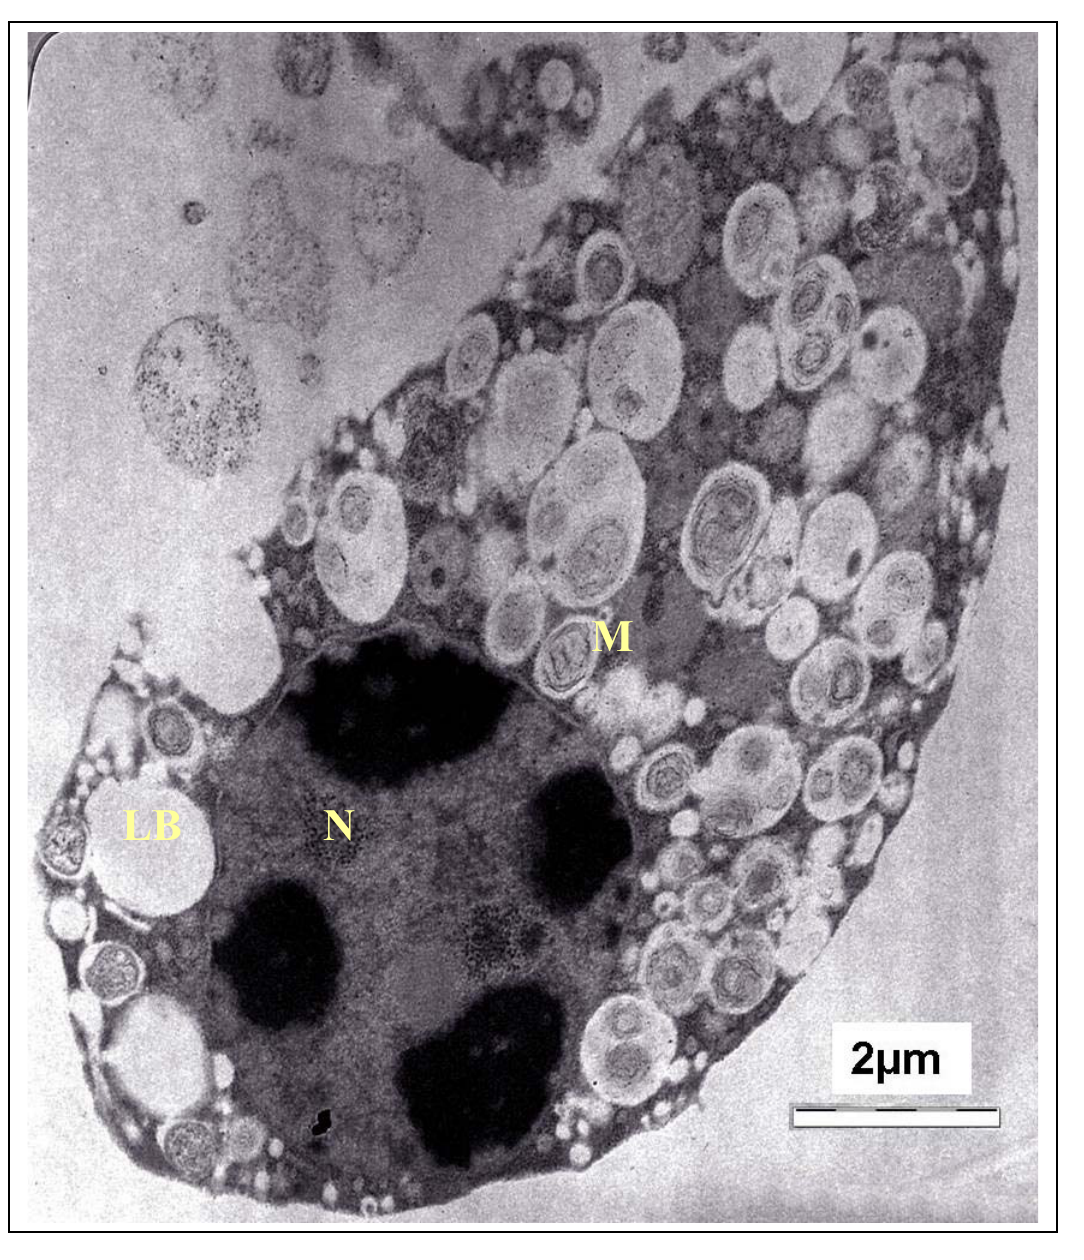
Figure 4. TEM micrograph of the control cells of T. gondii . M, mitochondrion; N, nucleus; LB, Lipid